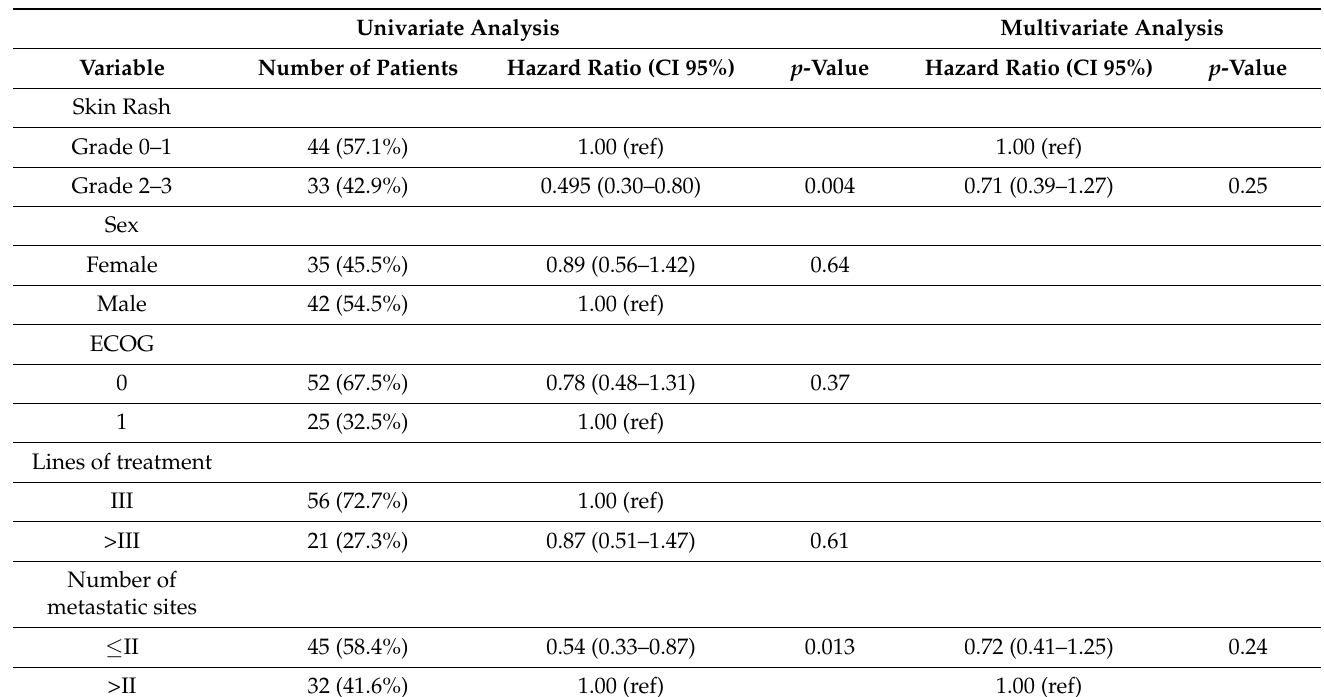
Table 1. Association of clinical variables with median progression-free survival by univariate and multivariate analysis. Univariate